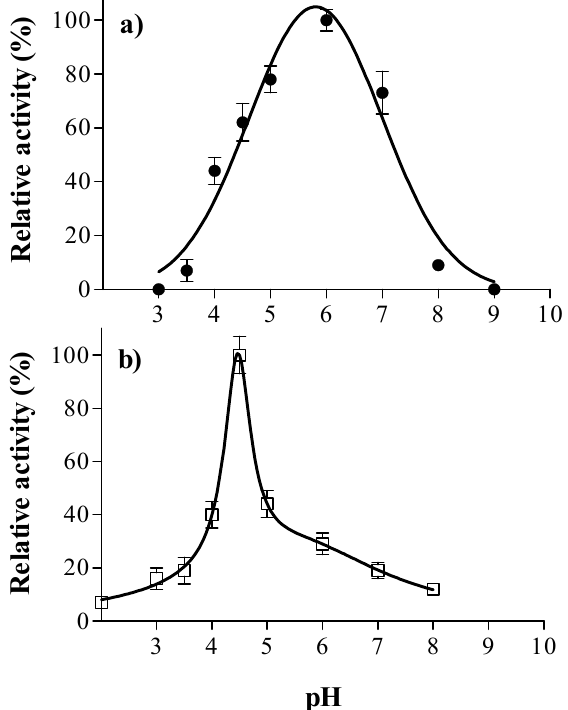
Figure 1. Effect of pH on the activity of laccase ( ● , ( a )) and tannase ( □ , ( b )) from A. oryzae. Assays were performed in McIlvaine buffer using syringaldazine (1 mM) as a substrate for laccase and tannic acid (1 mM) as a substrate for tannase. The points represent the average values, and the error bars represent the standard deviation of the three replicates.